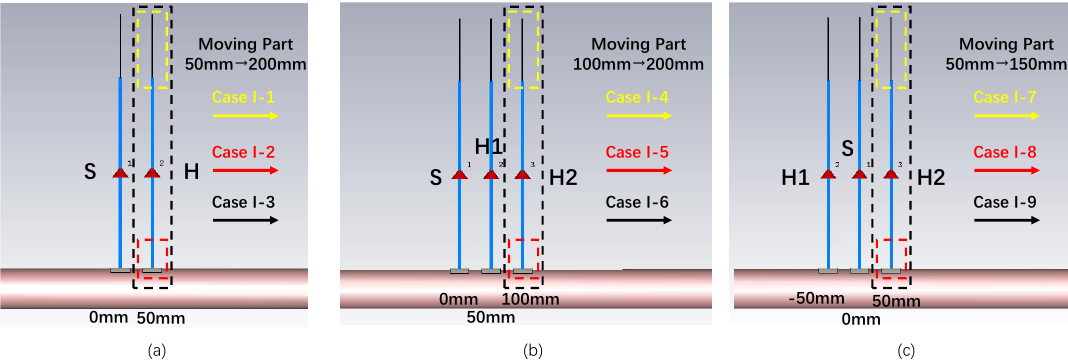
Figure 6. Simulation Case I. ( a ) Case I-1 ∼ Case I-3: The SSSH cases. In Case I-1, forward distance is fixed and backward distance changes. In Case I-2, backward distance is fixed and forward distance